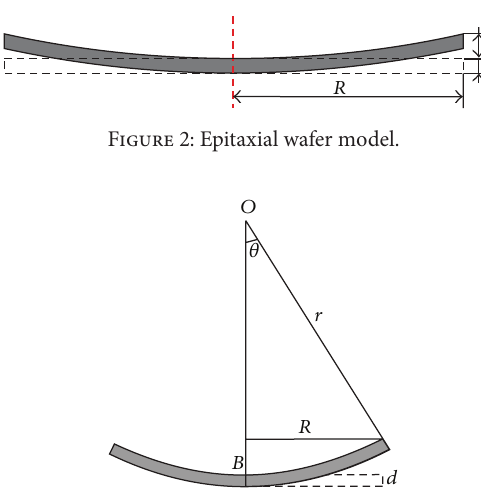
Figure 3: Epitaxial wafer bowing deformation schematic